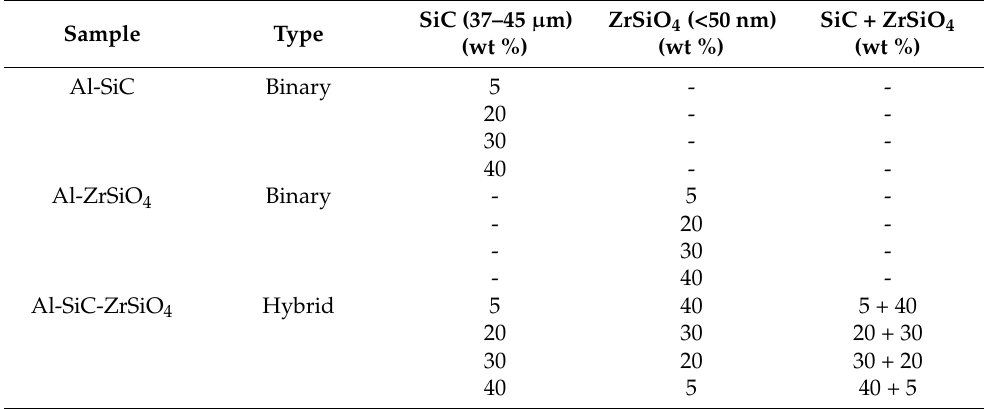
Table 1. Designed ratio of wt % of Al-powder and reinforcements in MMCs.